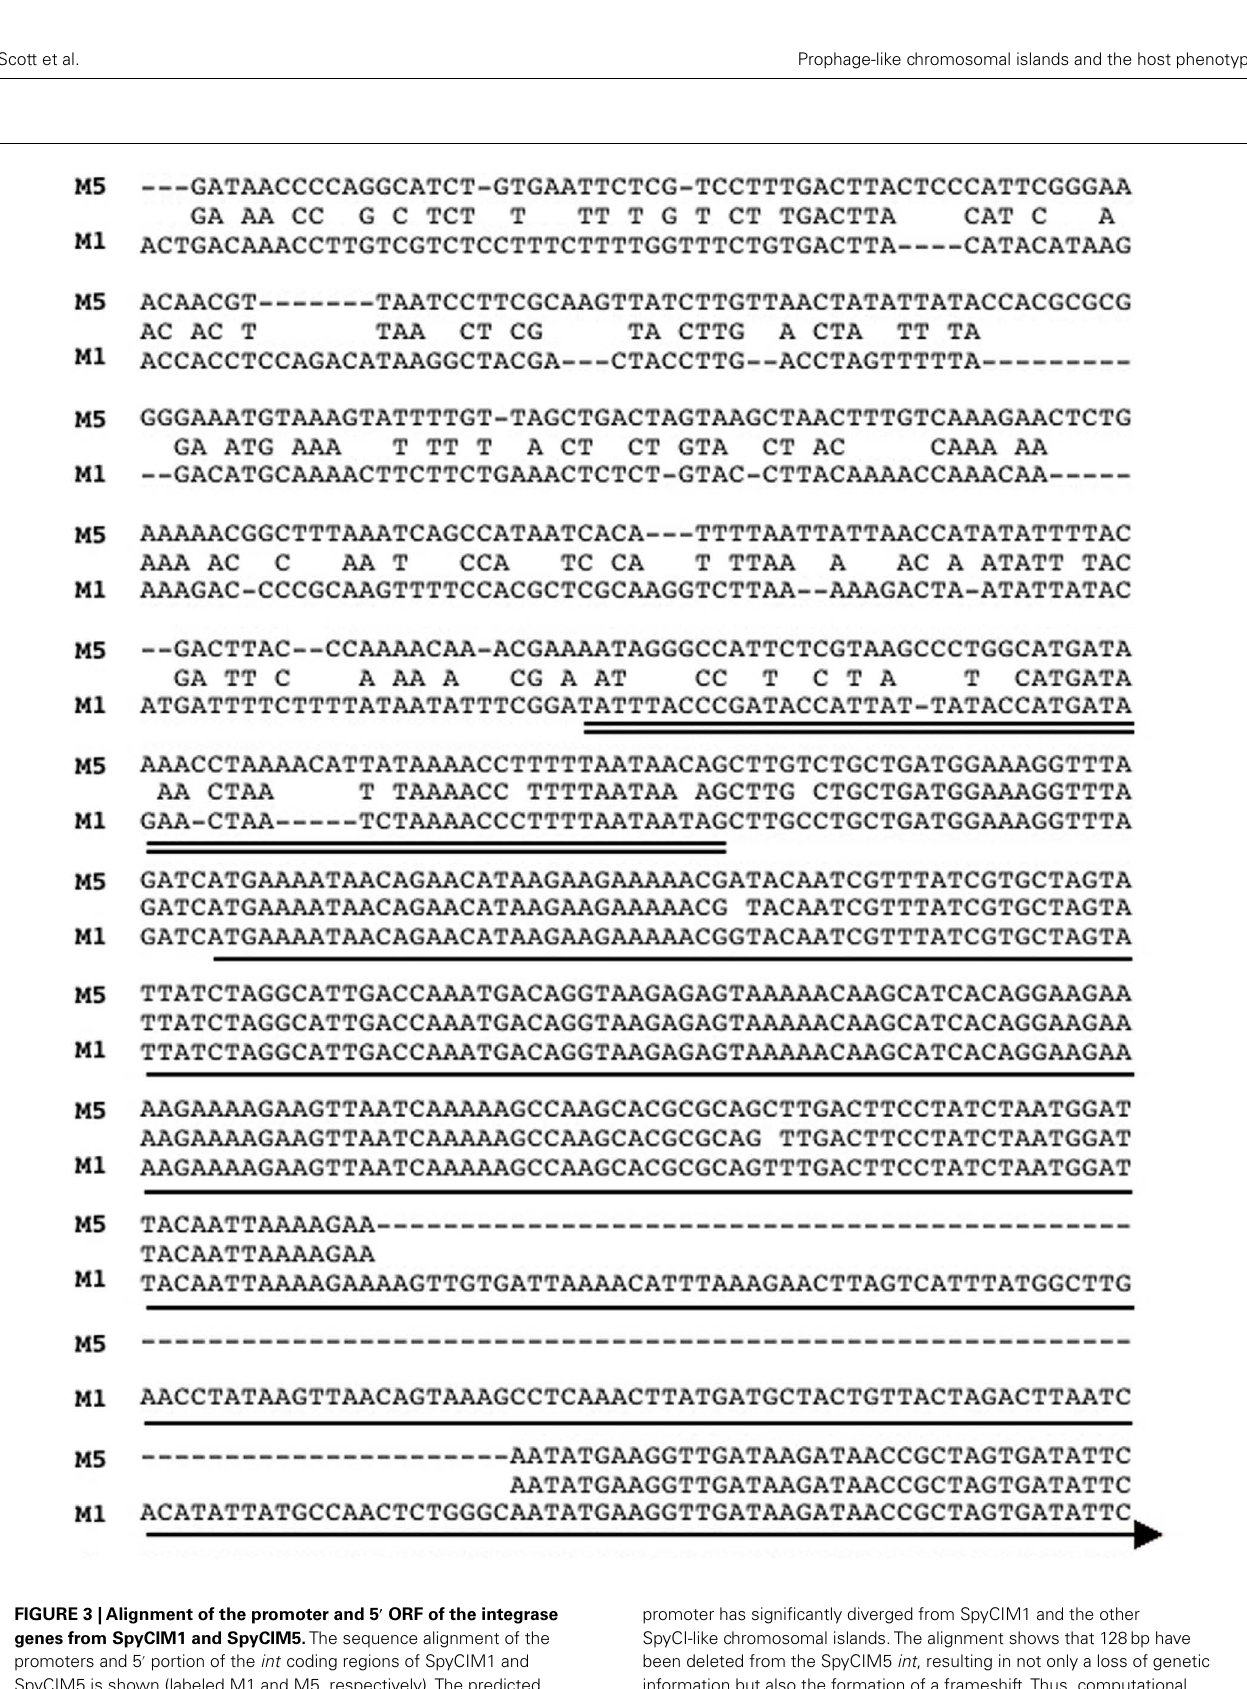
FIGURE 3 |Alignment of the promoter and 5 (cid:48) ORF of the integrase genes from SpyCIM1 and SpyCIM5. The sequence alignment of the promoters and 5 (cid:48) portion of the int coding regions of SpyCIM1 and SpyCIM5 is shown (labeled M1 and M5, respectively).The predicted promoter for SpyCIM1 int is double underlined, and the single line indicates the probable beginning of the coding region.The SpyCIM5